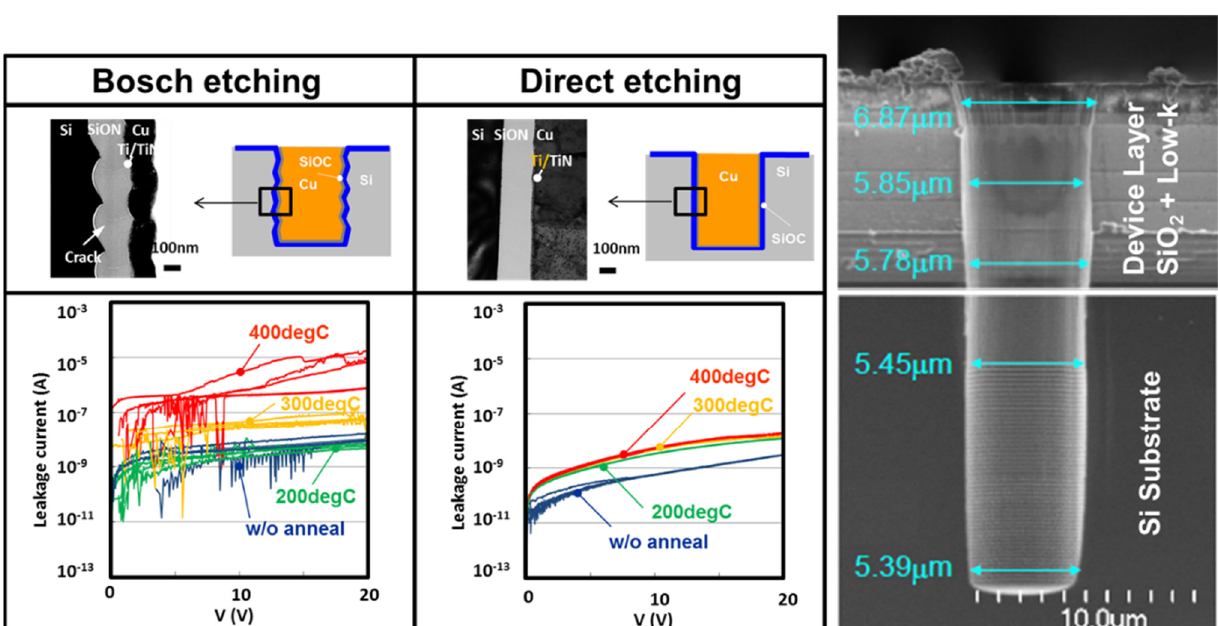
Figure 11. Schematic diagram, cross-sectional TEM images, and leakage current of two types of TSV samples made by Bosch etching and anisotropic dry etching ( left ). Cracks are observed in the Bosch-etched sample, which had a rough interface due to scalloping. The leakage current as a function of applied voltage after annealing at temperatures up to 400 ◦ C was measured. With increasing temperature, the leakage current increased but was two orders of magnitude higher in Bosch etching. SEM images of TSV etched off through Cu/Low-k BEOL layer, device layer, and Si after optimization of scalloping shape ( right ). Fine etching profile through BEOL and Si is achieved.